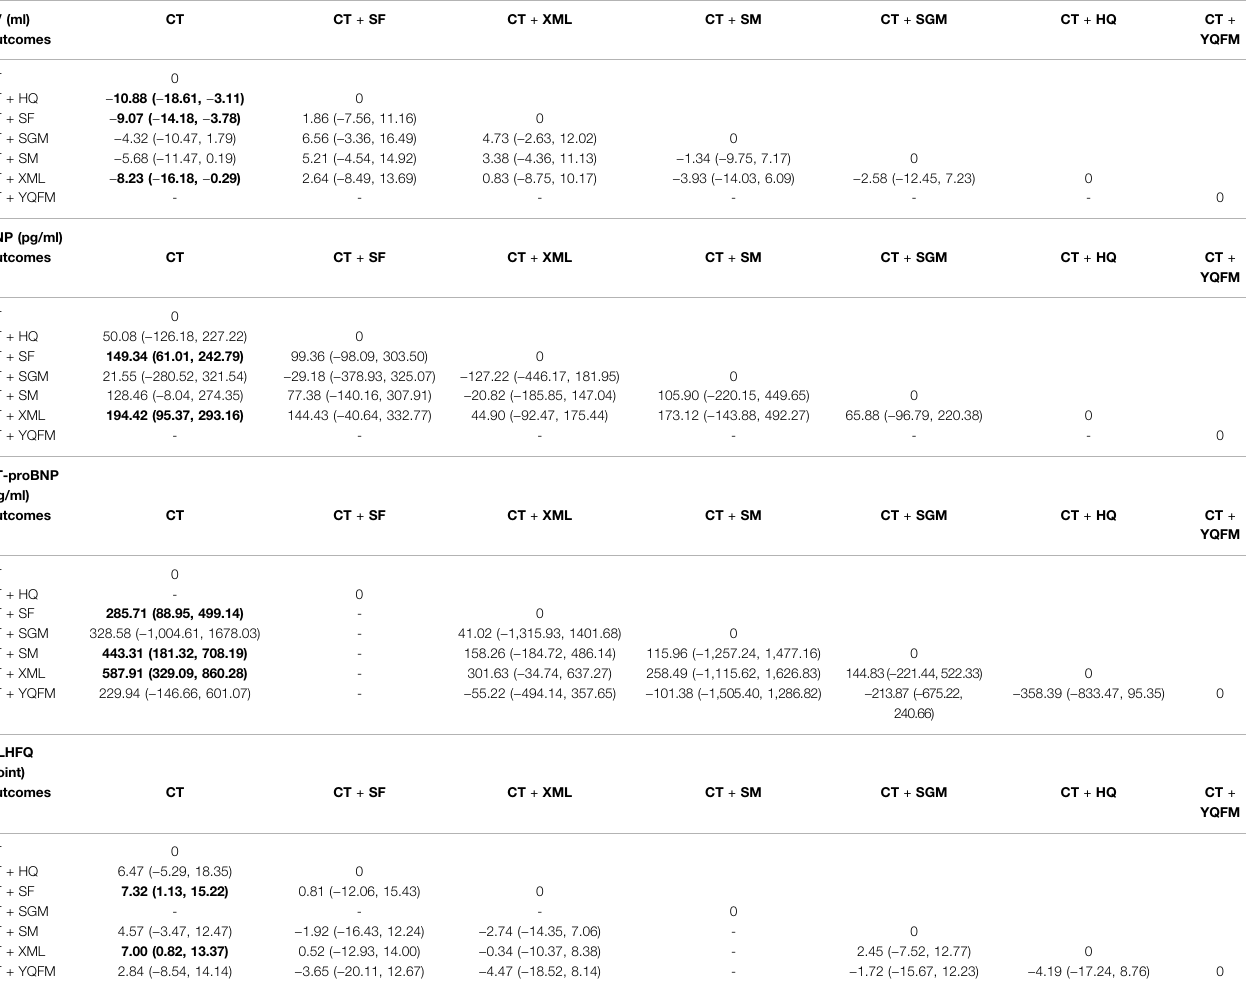
Figure 2 . All TCMIs combined with CT were superior to CT alone, and the difference was statistically signi fi cant. The details are shown in Table 2